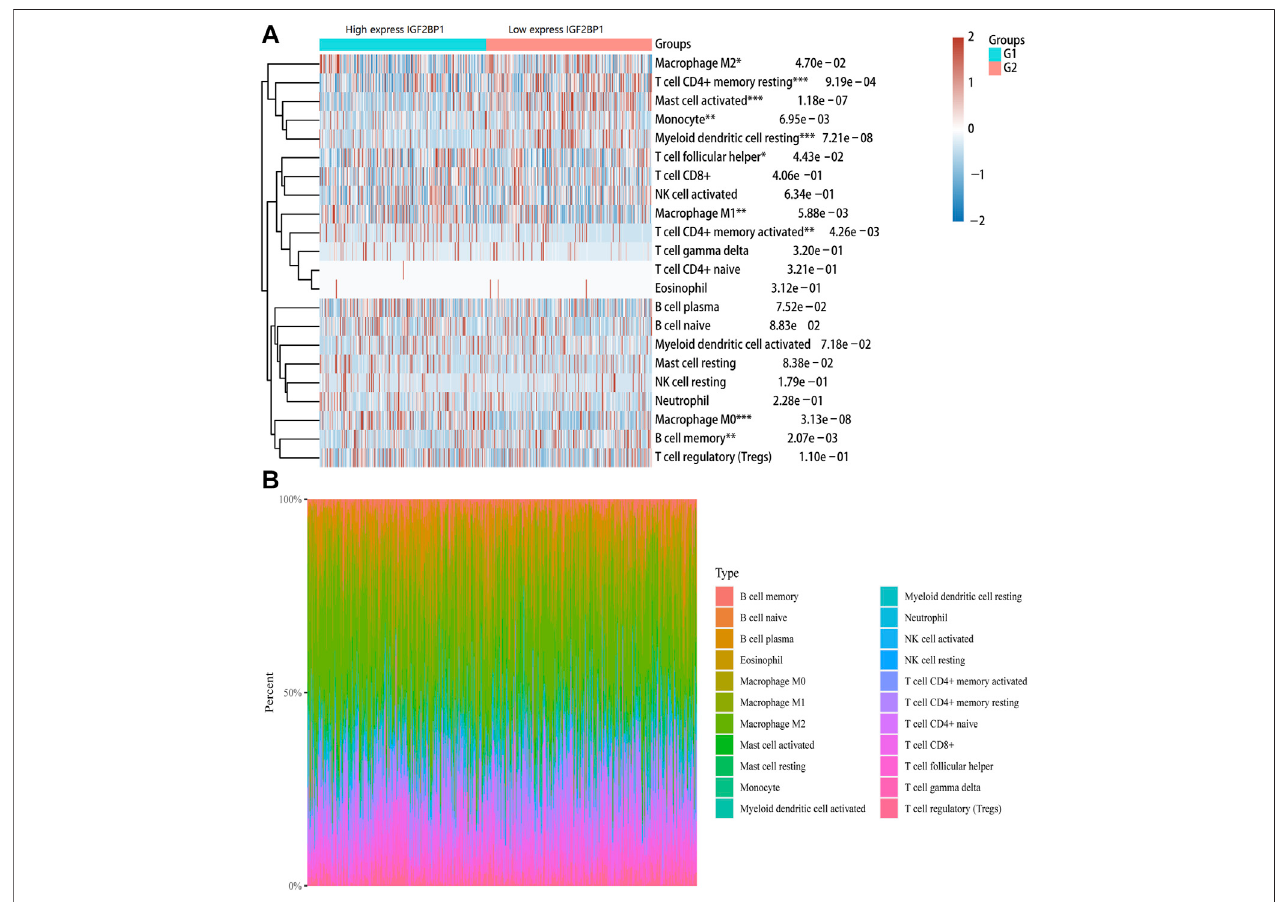
FIGURE 6 | Correlation between IGF2BP1 gene and immune cell in fi ltration in LUAD. (A) Immune cell in fi ltration score (CIBERSORT) heatmap, in which different colorsrepresenttheexpressiontrendindifferentsamples. (B) Percentageabundanceoftumor-in fi ltratingimmunecellsineachsample,withdifferentcolorsanddifferent types of immune